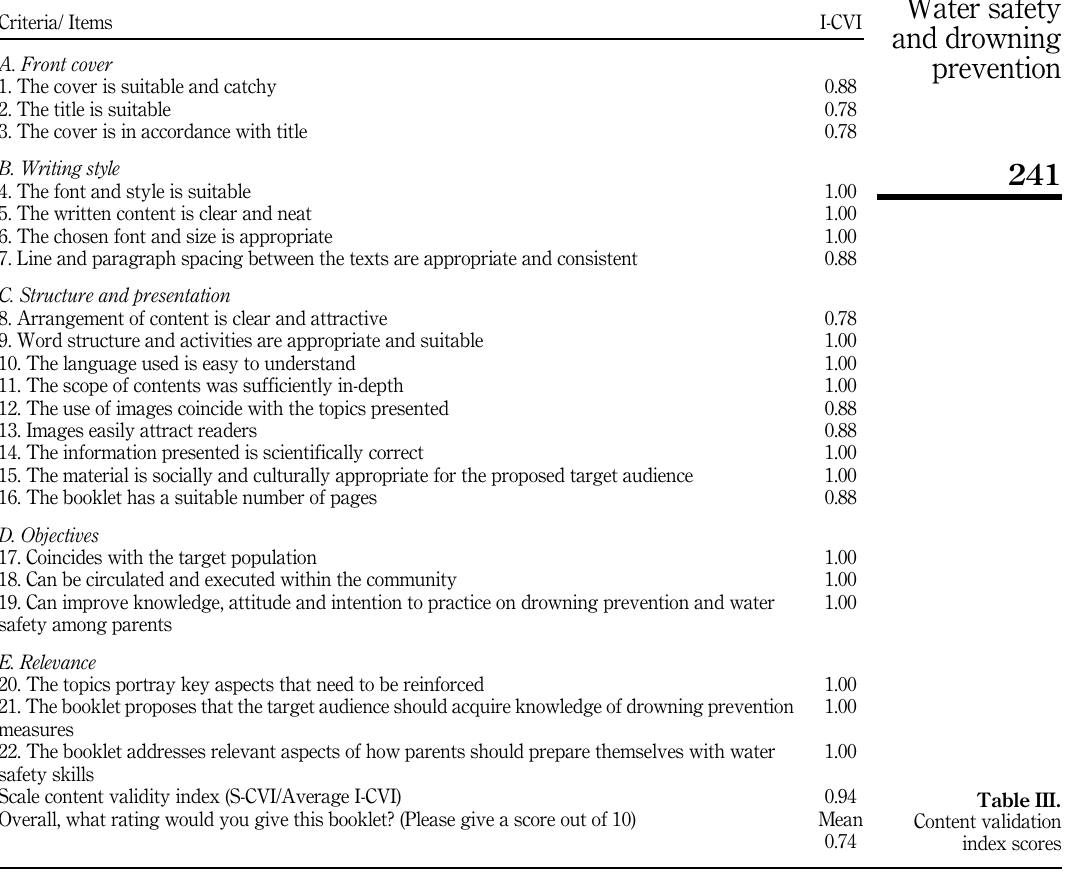
Table III. Content